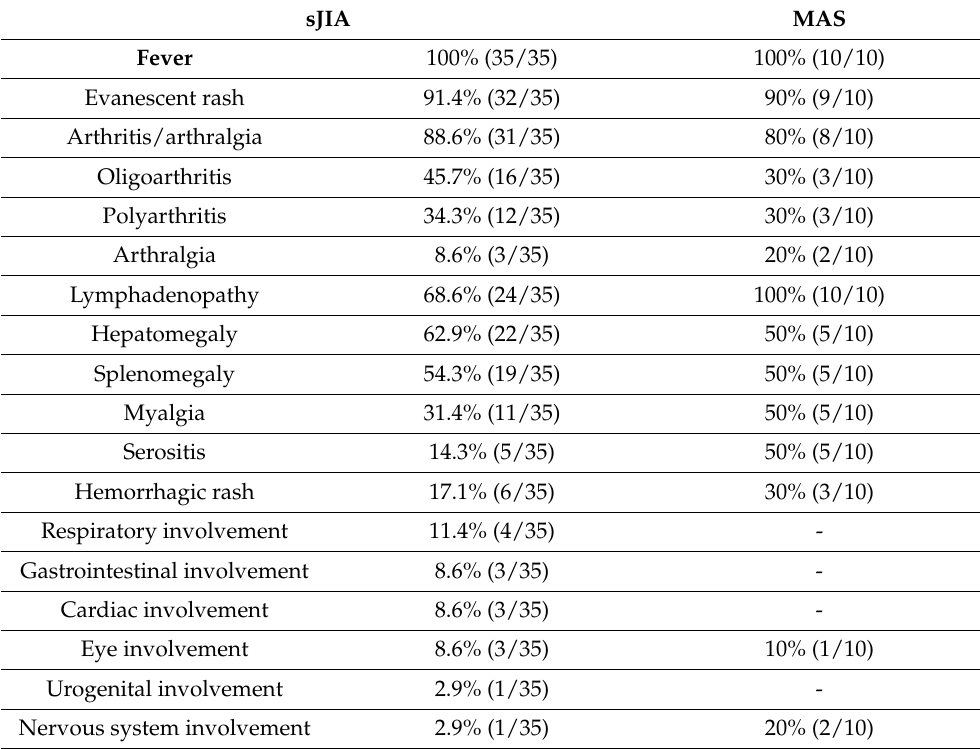
Table 2. Clinical features of sJIA patients and patients during MAS